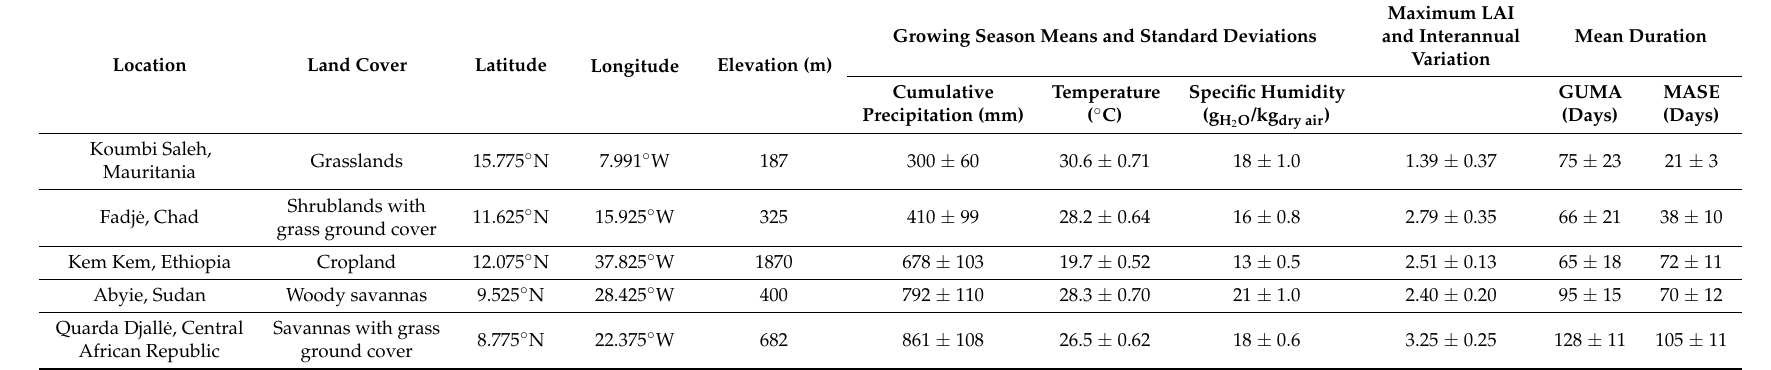
Table 1. Information on sites used for sensitivity studies. See Figure 1 for map of locations. GUMA: the period of Greenup to maturity. MASE: the period of Maturity to